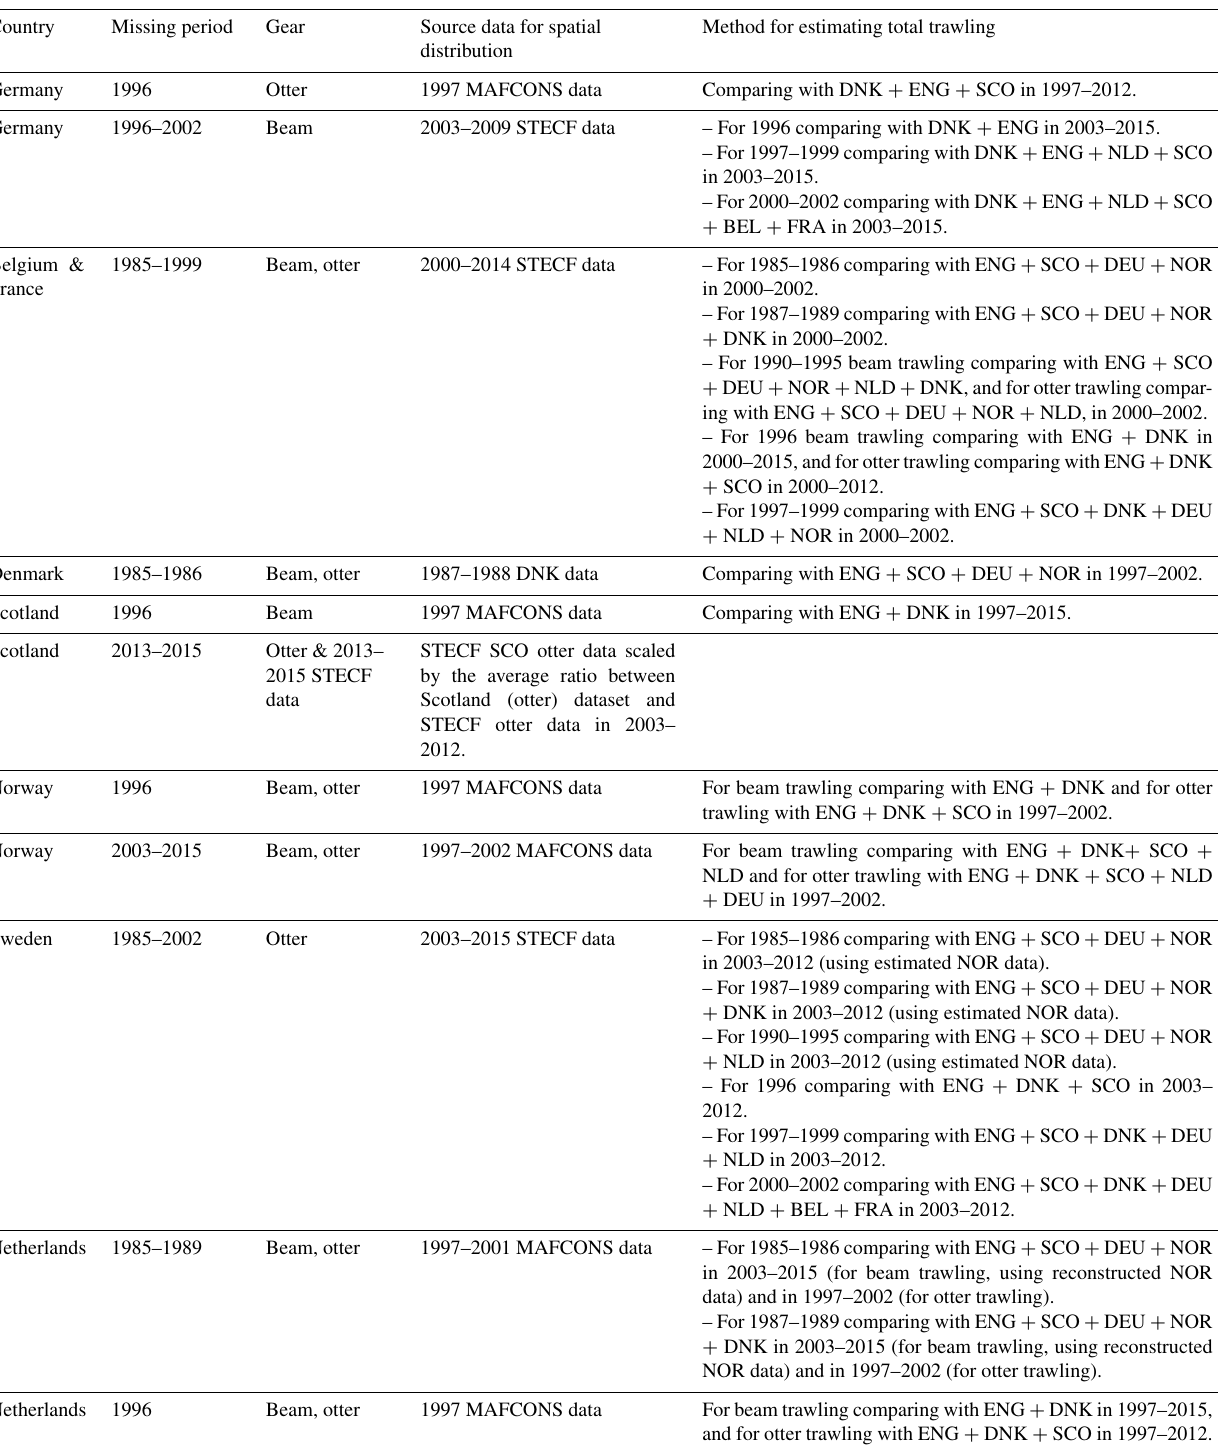
Table 1. Data used in the estimation of periods of missing data for each of the countries. An average spatial distribution of effort is calculated from the data in the “Source data for spatial distribution” column, and scaled to maintain the ratio of trawling by the target country with respect to the countries listed in the “Method for estimating total trawling”